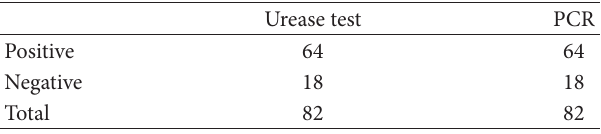
T 2: Comparison between PCR and urease test in fresh biopsy samples.